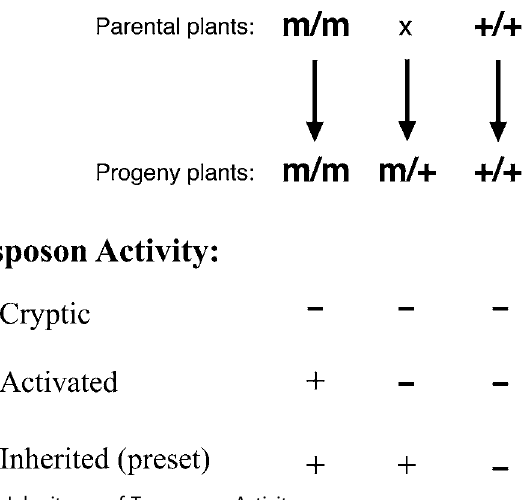
Figure 1. Inheritance of Transposon Activity Pollen from homozygous mutant plants (m/m) was crossed onto WT ( þ / þ ) to generate backcrossed BC heterozygous seed (m/ þ ). The parents were also self-pollinated as a control. Each class of progeny was then tested for expression of transposon mRNA, loss of DNA methylation, and changes in histone H3 methylation. Accumulation of transposon mRNA ( þ ) or lack thereof ( (cid:1) ) in each progeny genotype was used to determine whether the elements were silent ( ‘‘ cryptic ’’ ), reversibly activated, or heritably activated ( ‘‘ preset ’’